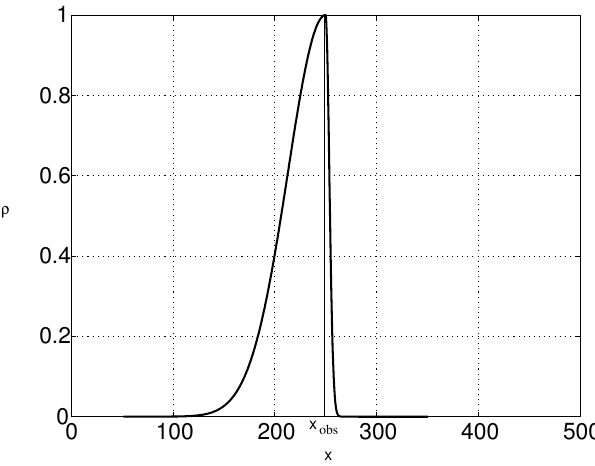
Fig. 2. Local anisotropic correlation function at observation point x obs